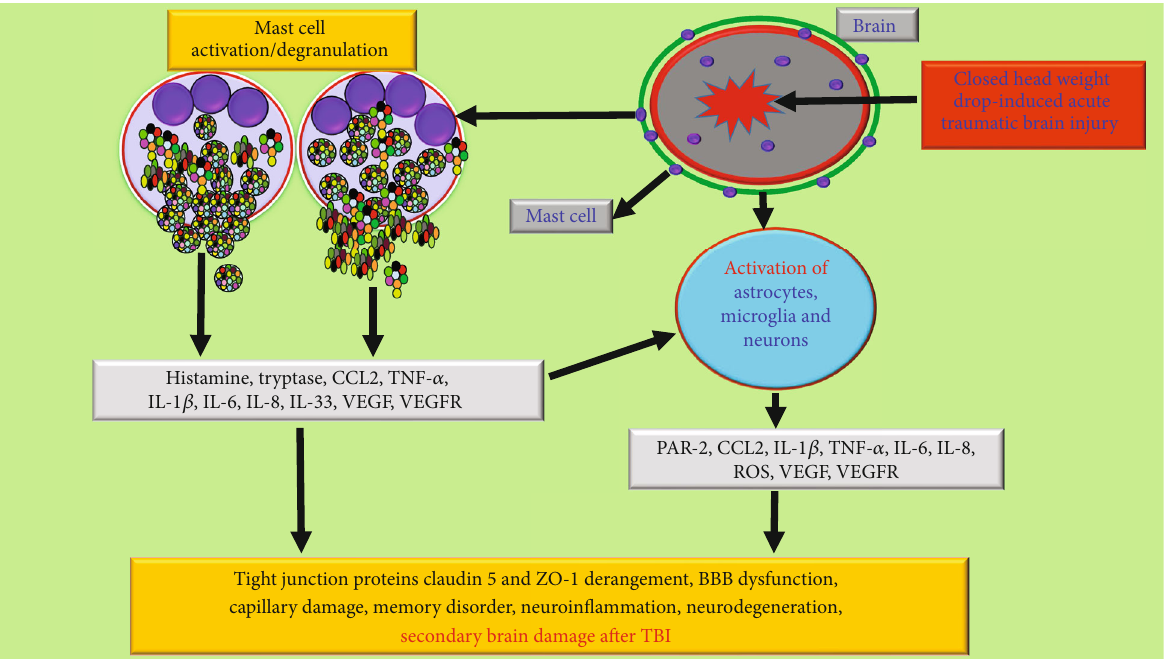
Figure 9: Schematic representation of mast cell activation in neuroin fl ammation, BBB disruption, and neuronal death in closed-head acute TBI brain. Neurotrauma/TBI can cause primary damage to neurovascular and gliovascular units in the brain with subsequent neuroimmune and neuroin fl ammatory responses. This leads to the activation of immune cells, including microglia, astrocytes, and mast cells in the brain. Mast cell activation causes degranulation and release of prestored and preactivated mediators such as histamine, proteases, and TNF- α followed by newly synthesized cytokines, chemokines, and neurotoxic mediators that can act on glial cells and neurons. Subsequently, peripheral immune as well as in fl ammatory cells can in fi ltrate the region of injury in the brain due to the BBB breach. CCL2 released from mast cells and brain cells induces the in fi ltration of in fl ammatory cells. Activated glial cells release neuroin fl ammatory mediators that further activate glial cells, neurons, and mast cells in a vicious fashion and induce PAR-2 and VEGFR2 expression and BBB breach with decreased tight junction protein such as claudin 5 and ZO-1 and its derangements. This continuous process can cause and upregulate neuroin fl ammation and neuronal death and secondary brain damage after